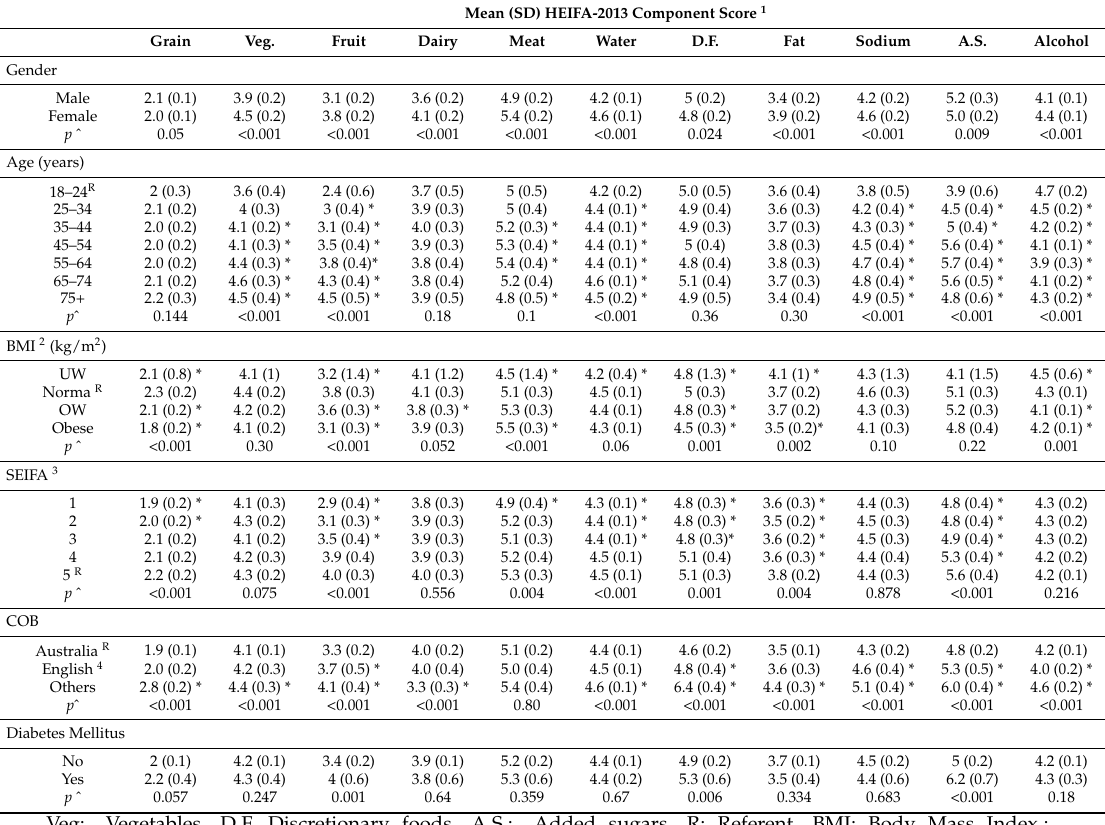
Table 2. Mean (SD) and mean differences for individual components of Healthy Eating Index for Australian Adults (HEIFA-2013) score (discretionary food, vegetable, fruit, grain, meat, dairy, water, unsaturated fat, sodium, and added sugar and alcohol scores) by demographic and socio-economic